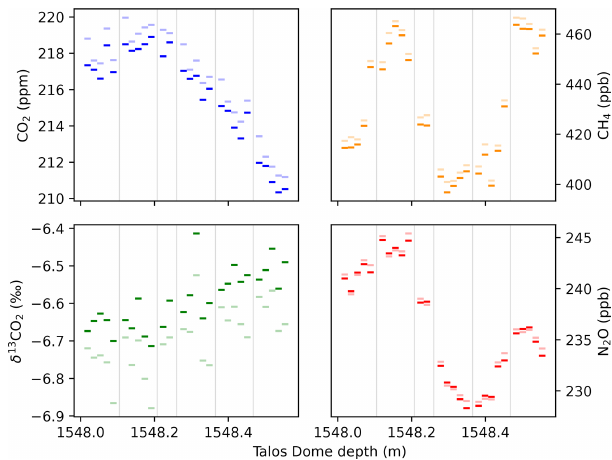
Figure 11. A 57cm section of the Talos Dome ice core ana- lyzed in ∼ 2cm resolution with the LISE/QCLS system described. Faded colors show the raw data (with calibration and drift correc- tion), while solid colors denote the same measurements but with a dip-tube-specific correction for average offsets deduced from the standard-over-ice experiments. Vertical gray lines separate individ- ual, ∼ 10cm long ice samples, which were sublimated yielding typ- ically five subsamples. The shorter sample with only two subsam- ples is due to a visible fracture at 1548.25cm depth.